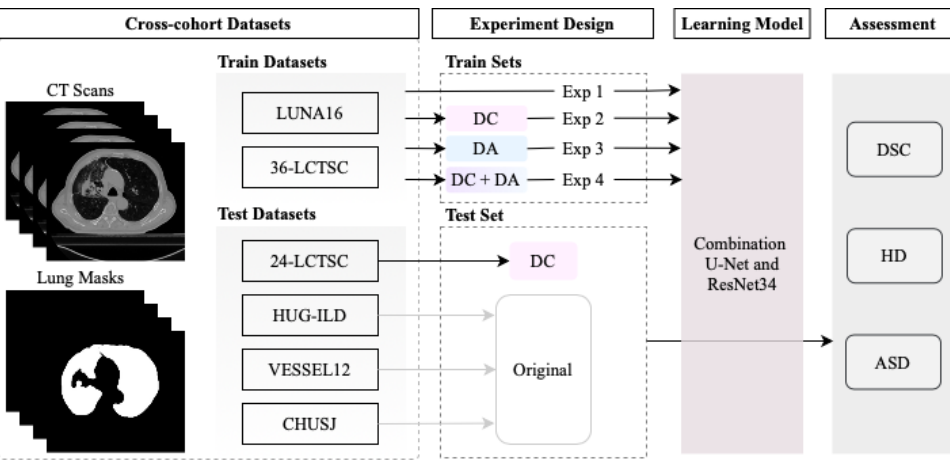
Figure 1. Overview of the segmentation model development using four experiments: trained with original annotations of the datasets in Experiment 1 (Exp 1); the corrected annotations in Experiment 2 (Exp 2); with data augmentation in Experiment 3 (Exp 3); and combining the corrected annotations with data augmentation in Experiment 4 (Exp 4). Three objective metrics were implemented to evaluate the performance of the segmentation model: the similarity coefficient (DSC), Hausdorff distance (HD), and average symmetric surface distance